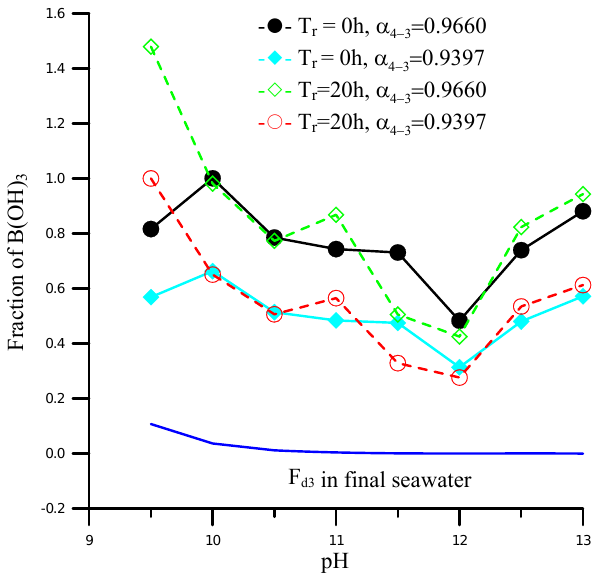
Fig. 5. Fraction F d3 of B(OH) 3 in brucite deposit and final seawater calculated according to δ 11 B d with different α 4-3 . The variation trend of F d3 for different repose time is basically same. F d3 tends to decrease with decreasing α 4-3 and is much higher than that of the initial artificial seawater (blue curve).